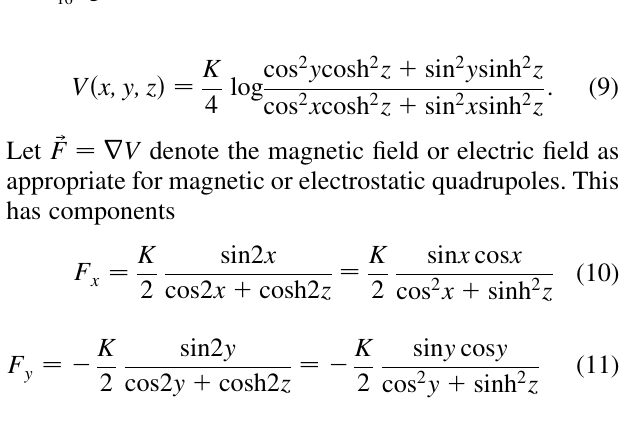
FIG. 1. Equipotentials of Eq. (8). Upper: in the z ¼ 0 plane, contours V ¼ 4 V V (green), V ¼ (cid:2) V 0 0 16 (beige), and V ¼ (cid:2) 4 V contours V ¼ 4 V V ¼ V 0 16